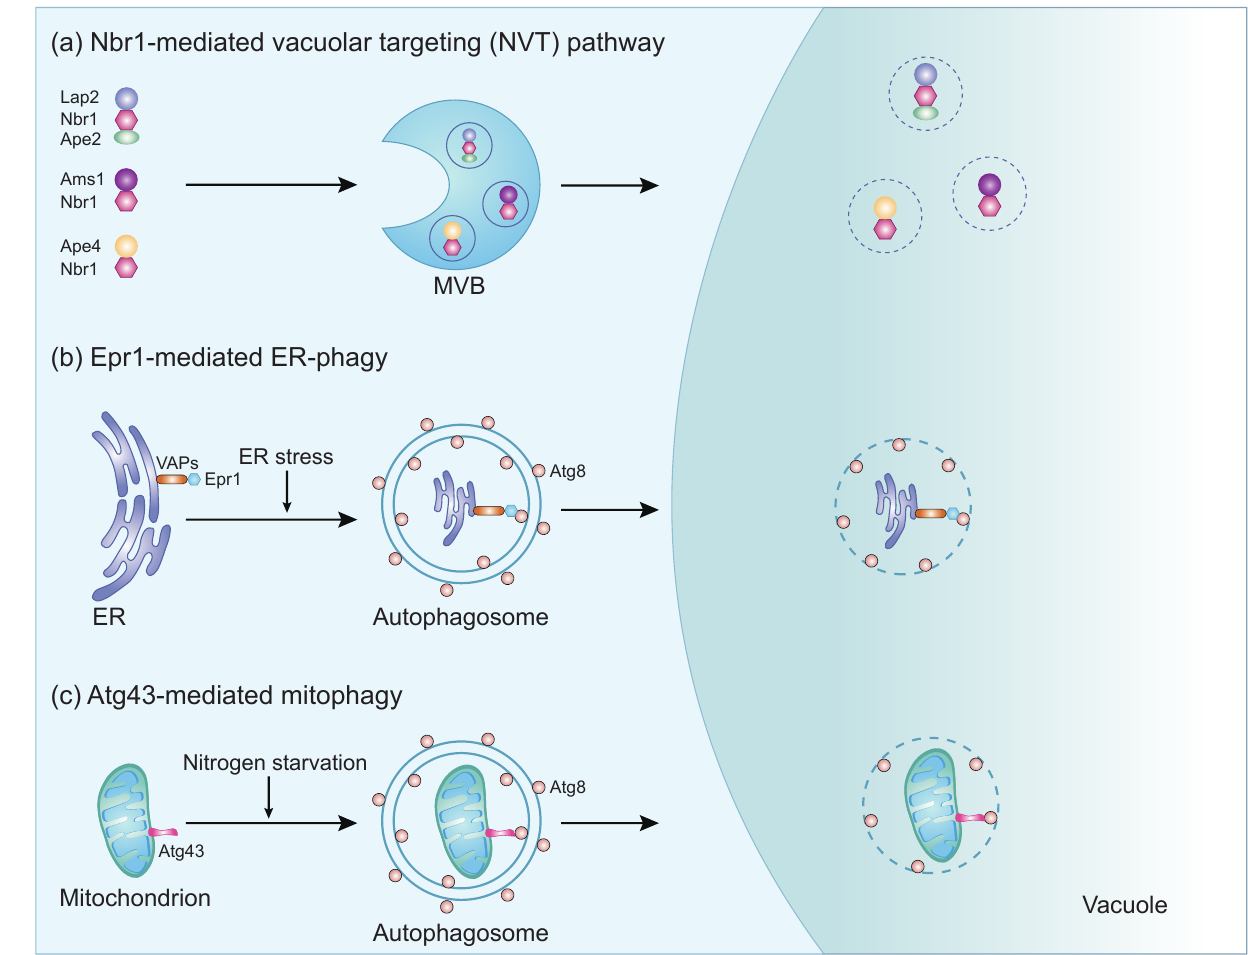
Figure 2. Three types of selective autophagy in fission yeast. ( a ) NVT cargos form three separate complexes with Nbr1 and are delivered into the vacuole through the multi-vesicular body (MVB). ( b ) The soluble ER-phagy receptor Epr1 localizes on the ER through interacting with integral ER membrane proteins VAPs. Under ER stress conditions, the Epr1–Atg8 interaction promotes the engulf- ment of ER fragments into autophagosomes. ( c ) Atg43 is a mitochondrial outer membrane protein. During nitrogen starvation, the Atg43-Atg8 interaction promotes the engulfment of mitochondria into